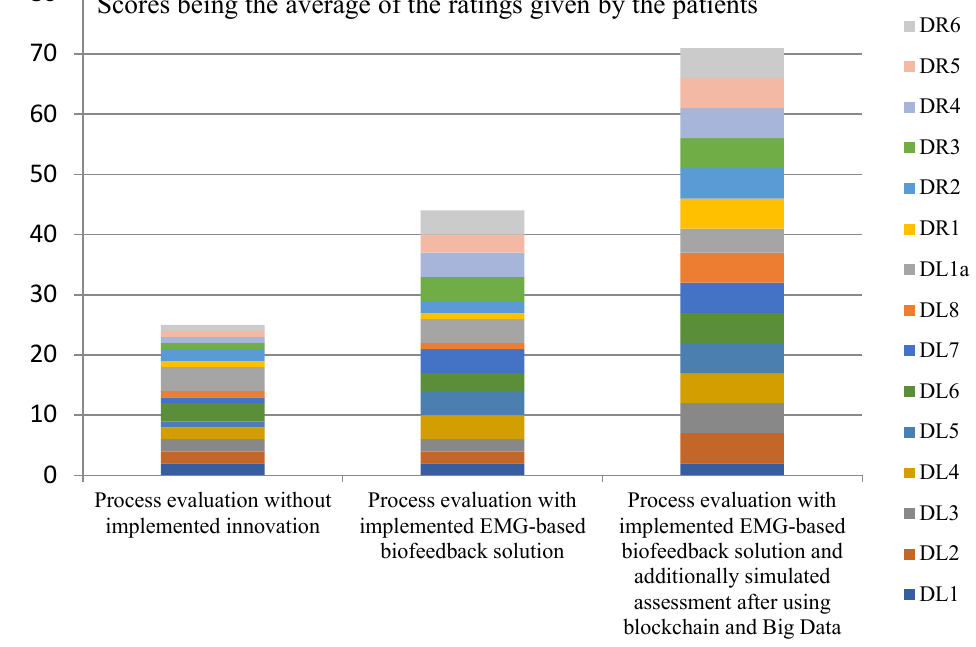
Figure 3. Assessments of the process steps in terms of the creation of values for the patient’s mental health. Source: Authors’ own elaboration based on primary studies.